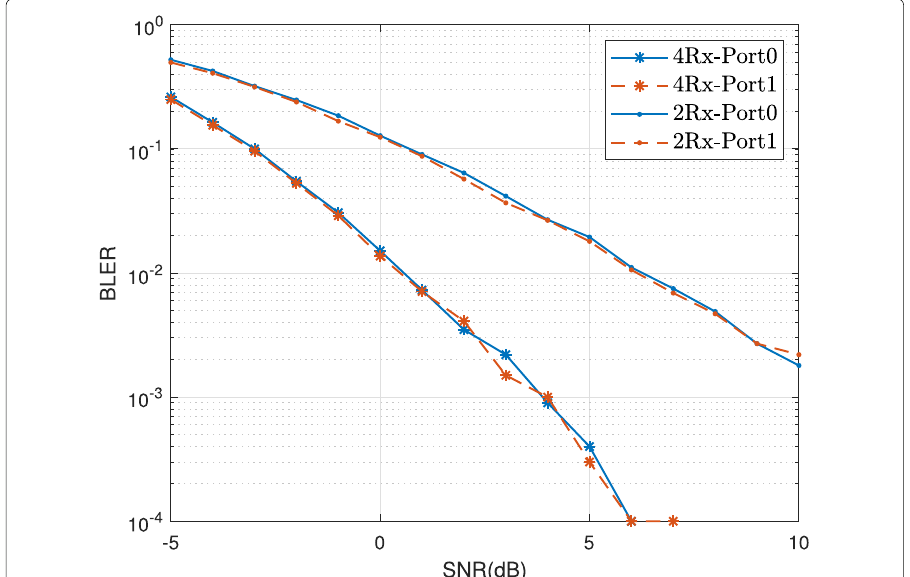
Fig. 23 BLER comparison of length-6 DMRS sequences on port 0 and port 1 with proposed transmitter